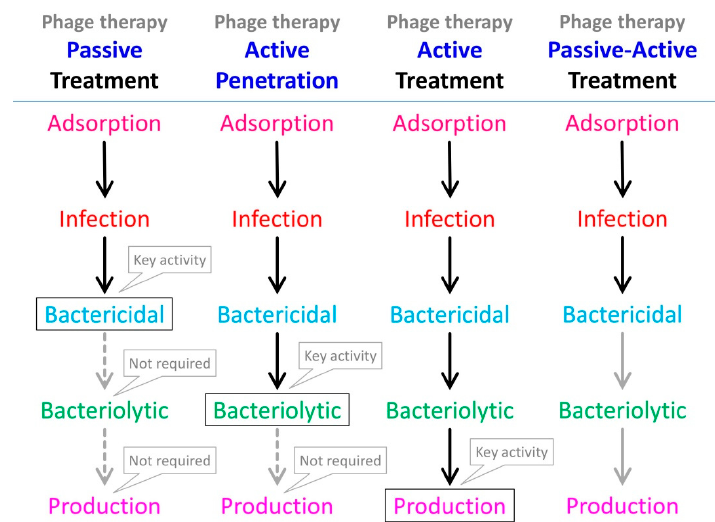
Figure 1. Progression of phage life cycles (top to bottom) and illustration of di ff erent phage therapy strategies (left to right) as requiring di ff erent degrees of phage infection activity. All terms refer to phage activities rather than antibiotic activities, including phage killing of bacteria (bactericidal), phage lysing of bacteria (bacteriolytic), and phage-infection generation and release of new virion particles (production). Boxes indicate key phage infection activities for a given strategy. Arrows indicate phage infection progressions from top to bottom, i.e., from bacterial adsorption, to bacterial infection, to bacteria killing, to lysing of bacteria, and then to release of new virions (production). Graying of arrows indicates a lack of requirement for this progression (dashed gray arrows) or lack of strict requirement (solid gray arrows) for a given phage therapy strategy (which are named across the top row). Passive treatment (first column) uses bacteria-overwhelming (inundative) phage dosing and thus requires